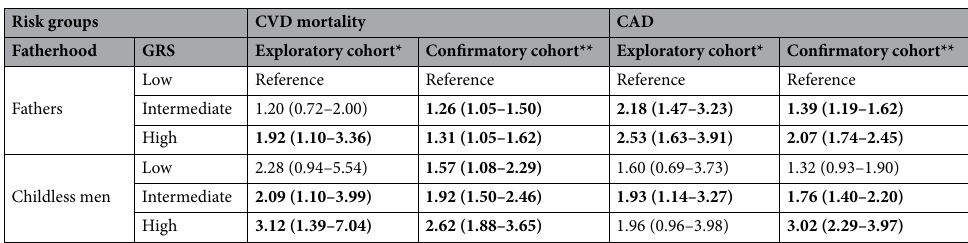
Table 3. Risk of cardiovascular (CVD) mortality and coronary artery disease (CAD) among study groups with GRS 50 with corresponding hazard ratios (HR) and 95% confidence intervals (95% CI). Figures in bold indicate statistical significance in MDC—CVC (exploratory) and MDC (confirmatory) cohorts. Models are adjusted for: *Exploratory analysis: age, smoking, alcohol intake, BMI, hypertension, family history of CVD, cholesterol, triglycerides, and marital status. **Confirmatory analysis: age smoking educational status, BMI, marital status, family history of CVD, prevalent